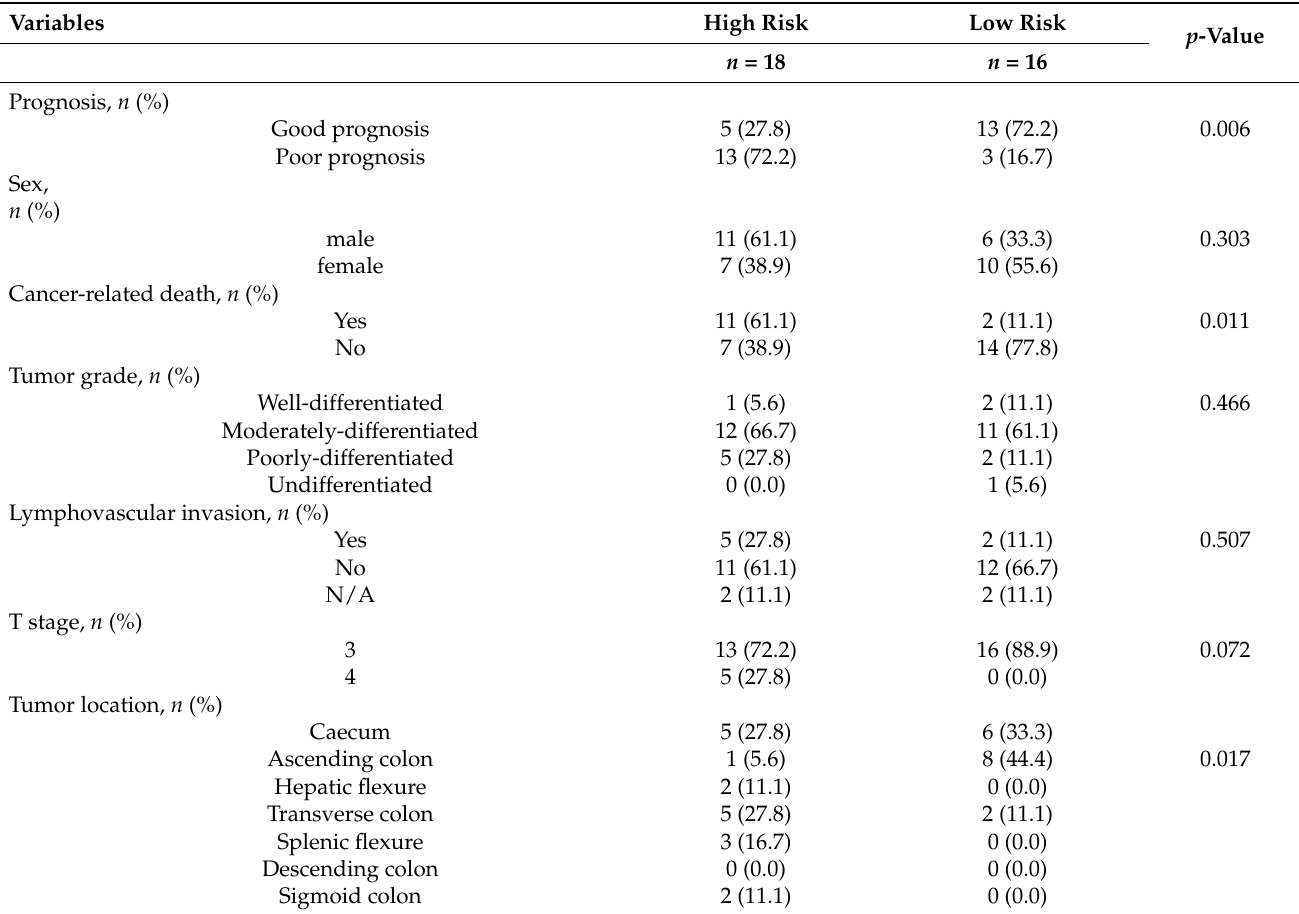
Table 2. Baseline characteristics of the patients with stage II CRC in array